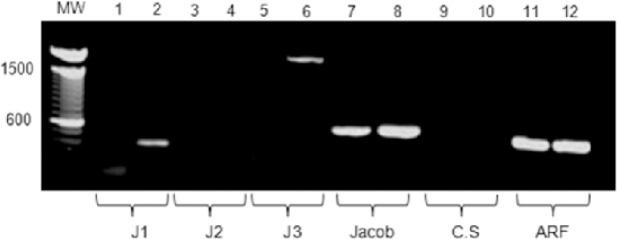
RT-PCR of transcripts encoding for cyst wall proteins in trophozoites and CLS.RNA was isolated from trophozoites and CLS samples and used to perform a RT-PCR for a number of cyst wall specific proteins: Jessie 1 (J1), Jessie 2 (J2), Jessie 3 (J3), Jacob, and chitin synthase (CS). RT-PCR of the ADP-ribosylation factor (ARF) was used as an internal control. Odd numbers: trophozoites samples; even numbers: CLS samples.